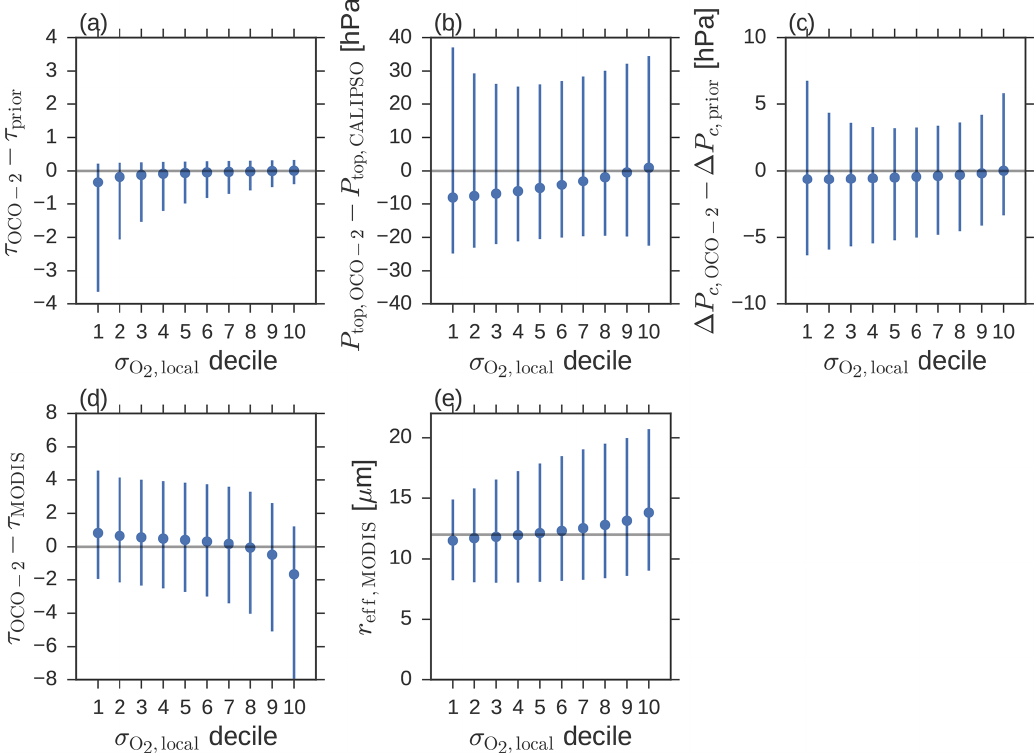
Figure 9. Statistics of Quality_flag = 0 cloud cases split into deciles based on the standard deviation of continuum A-band radiances in neighbouring footprints divided by the footprint’s continuum. The points are the bin medians, and the bars cover the 14th–86th percentiles. (a) OCO-2 posterior minus prior τ , (b) OCO-2 minus CALIPSO P top , (c) OCO-2 posterior minus prior (cid:49)P c , (d) OCO-2 minus collocated MODIS τ and (e) collocated MODIS r e . The horizontal line in (e) is at r e , h = 12µm to indicate the OCO2CLD-LIDAR-AUX assumed